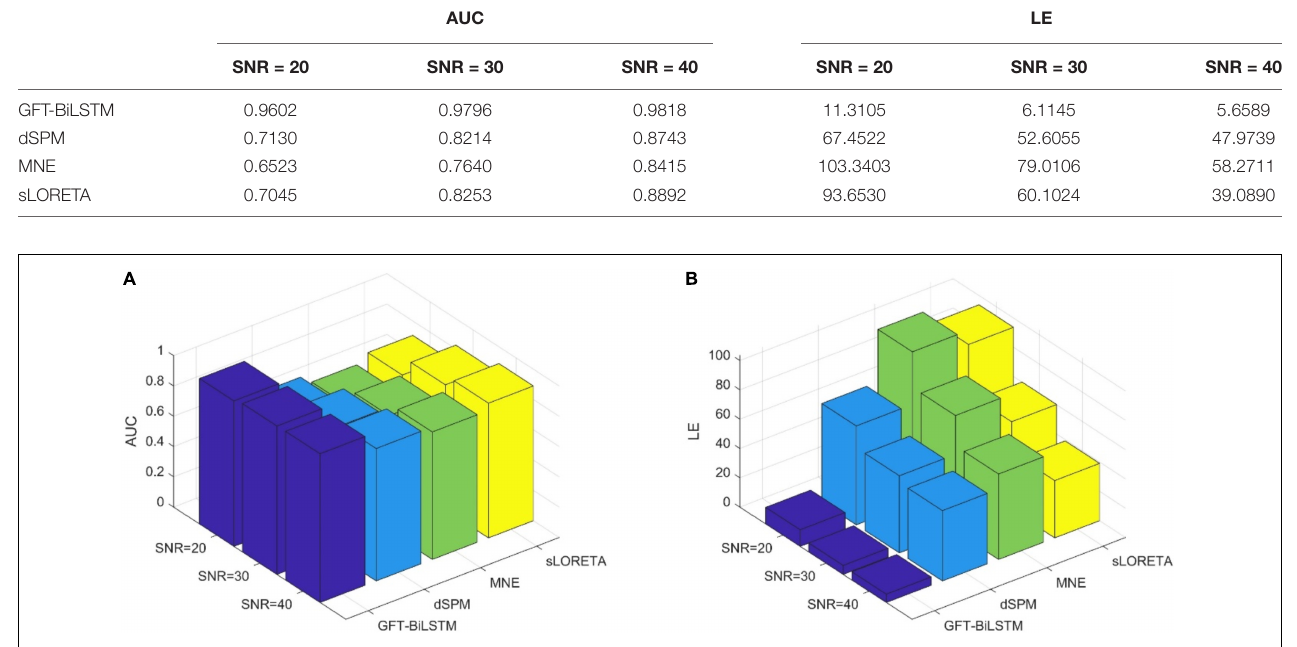
FIGURE 7 | The performance metrics comparison of different ESI inverse solutions with multiple activated areas. (A) The comparison of AUC at different SNR levels. (B) The comparison of LE at different SNR levels.